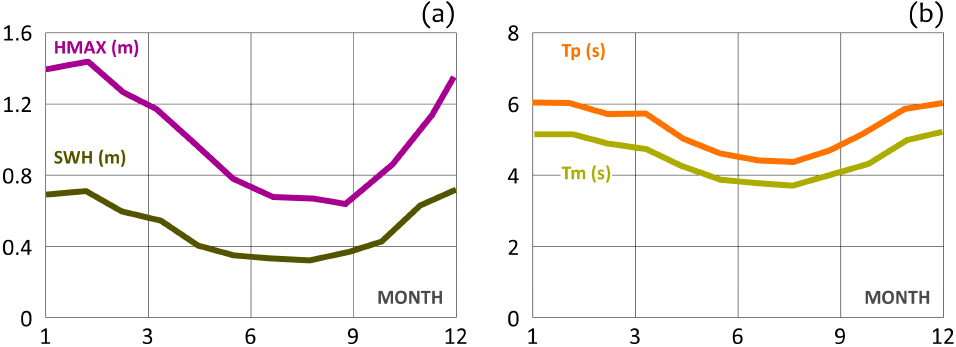
Figure 7. MESCT, ERA5 dataset 1950–2019, time step of 6 h. Monthly average of: ( a ) SWH (mustard) and HMAX (purple), ( b ) Tm (yellow) and Tp (orange).